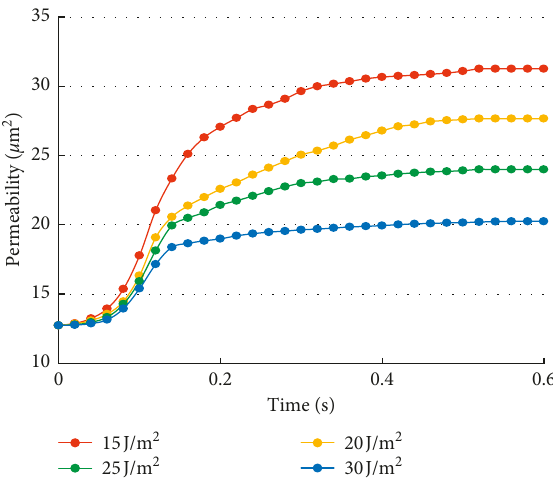
Figure 8: Permeability coefficients under different cohesive forces.